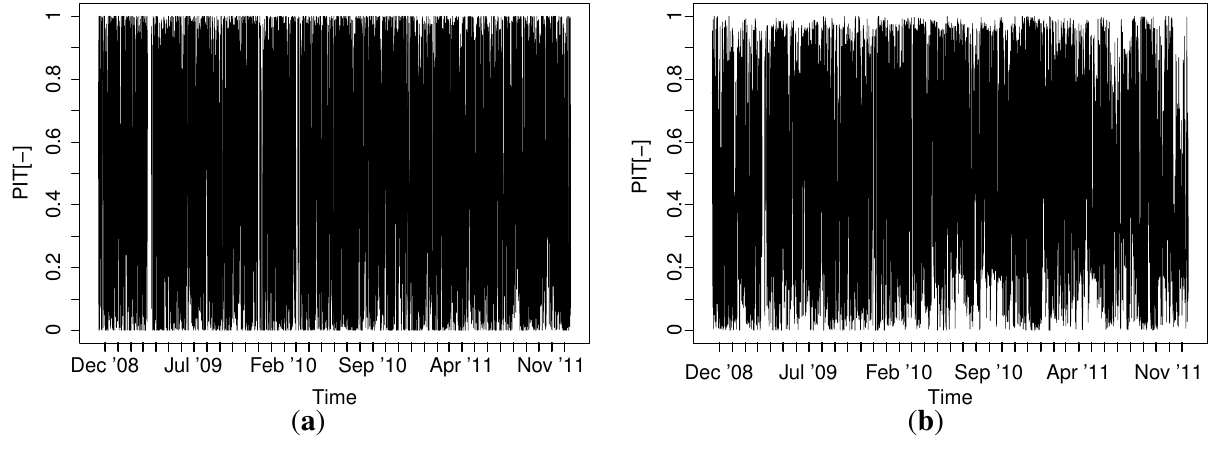
Figure 7. The probability integral transform (PIT) of ε QR-E model ( b ).